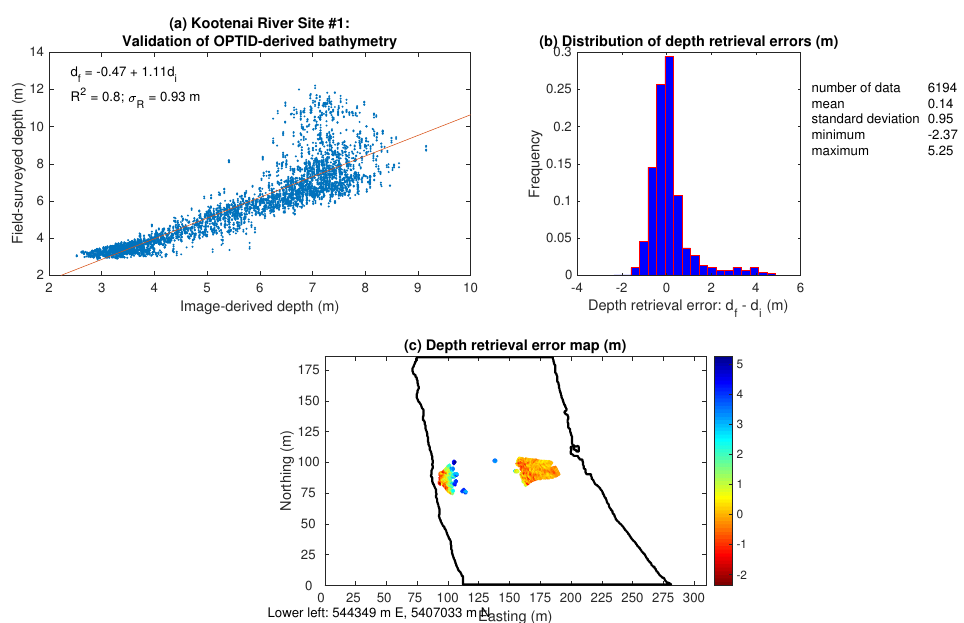
Figure 11. Accuracy assessment of image-derived bathymetry based on validation subset of the field-based depth measurements from the MBES survey. ( a ) Observed versus predicted regression; ( b ) distribution of depth retrieval errors; ( c ) error map for depths less than the OPTID-inferred d max . Depth retrieval errors, (cid:101) , thus were positively biased on average, with a mean error of 0.14 m, or 1.4% of the mean of the validation depths on which this analysis was based (i.e., points